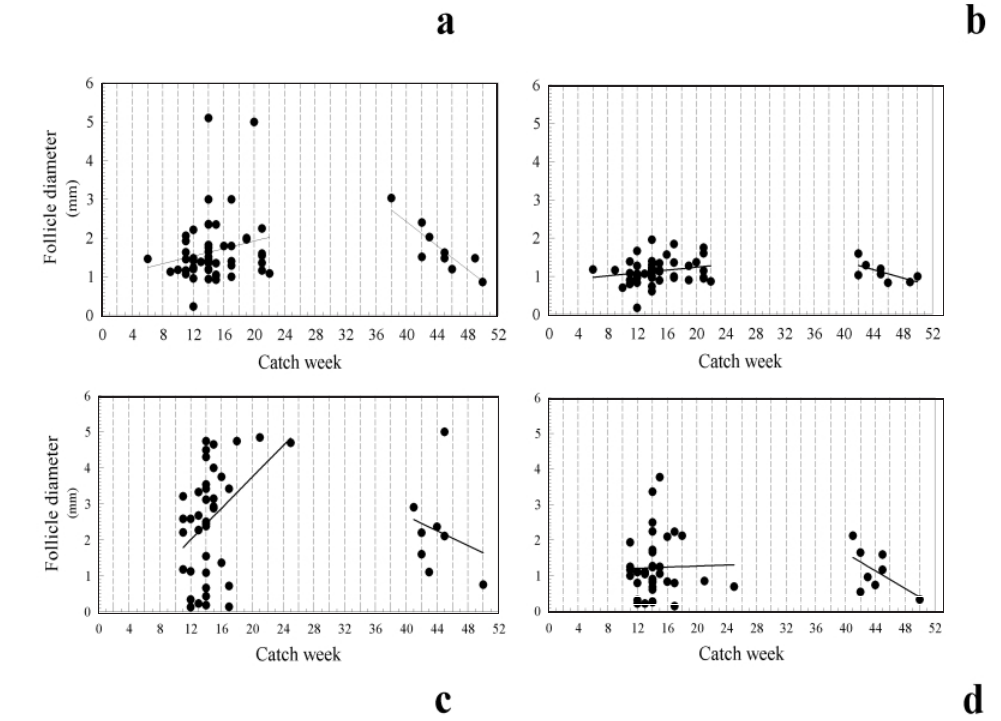
Fig. 5. Seasonal variation in follicle diameters of left (a) and right (b) ovaries in mature ani- mals by catch week and of left (c) and right (d) ovaries in immature animals two years of age or older. Linear regression lines are shown.